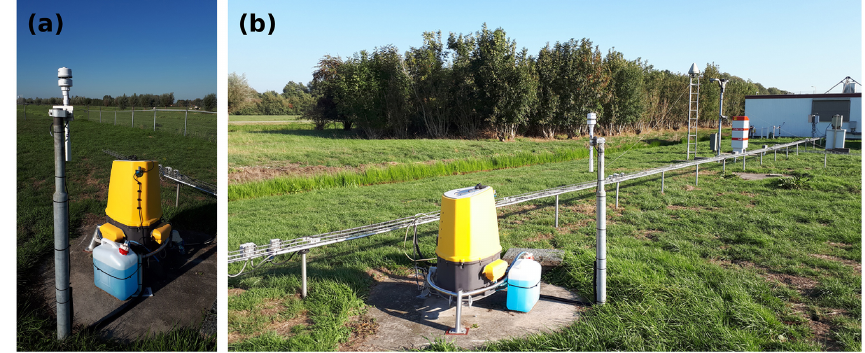
Figure 15. Photos of (a) the meteorological station of ZephIR 300 instrument located on a separate pole and (b) a view to the southeast direction, showing building on RSS and nearby trees.